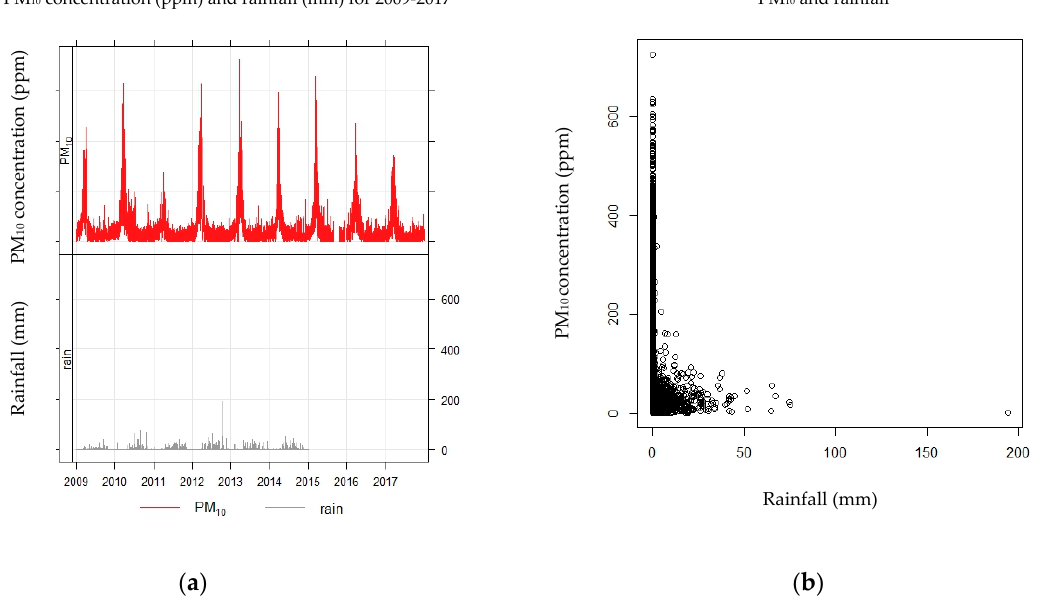
Figure 2. ( a ) PM 10 concentration(ppm) and rainfall (mm) for 2009-2017, ( b ) PM 10 and rainfall.